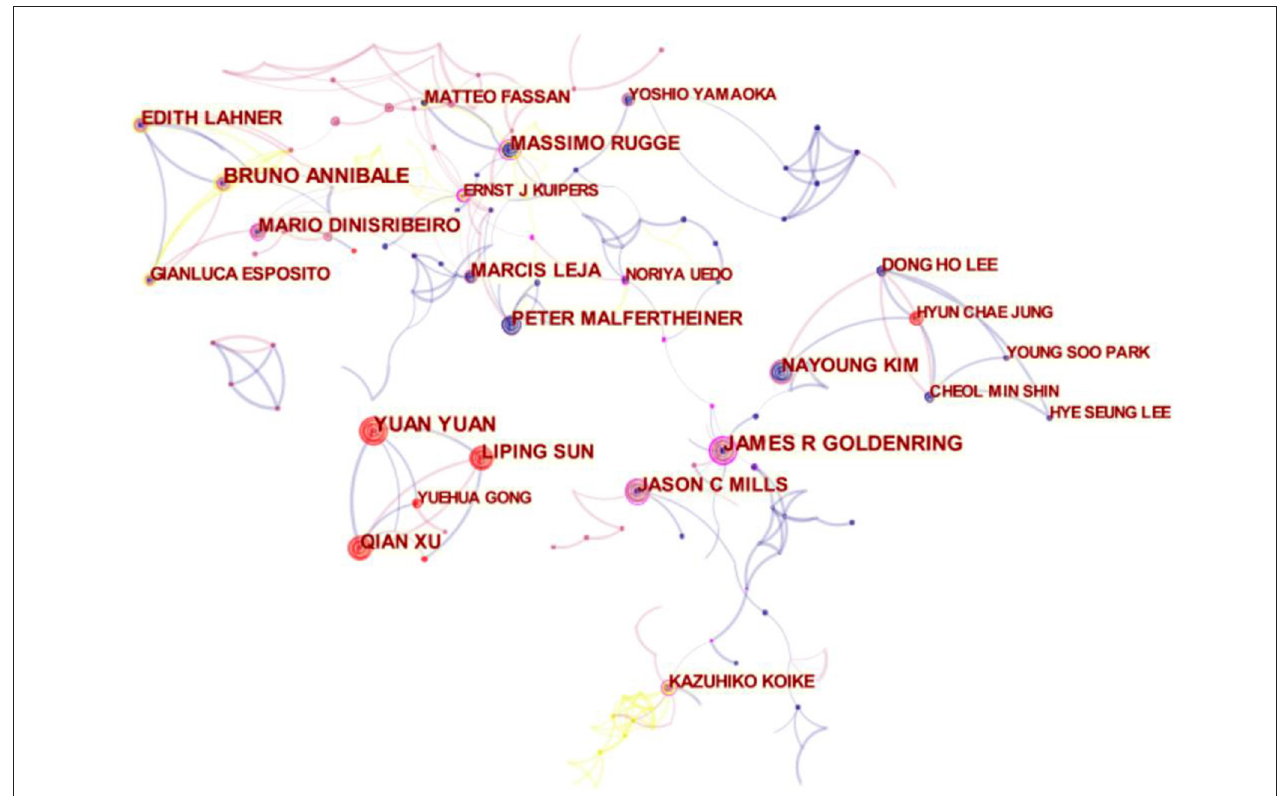
FIGURE 4 | Network of authors in AG